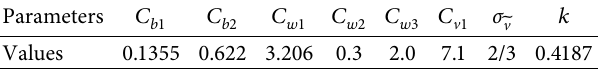
Table 2: Some parameter